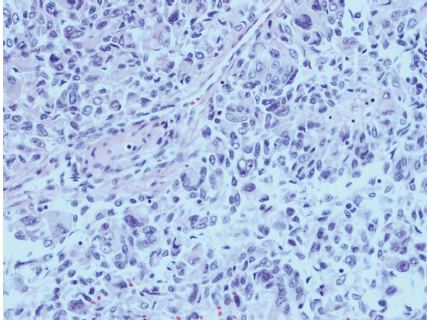
Figure 1: PET CT showing left lobe mass.